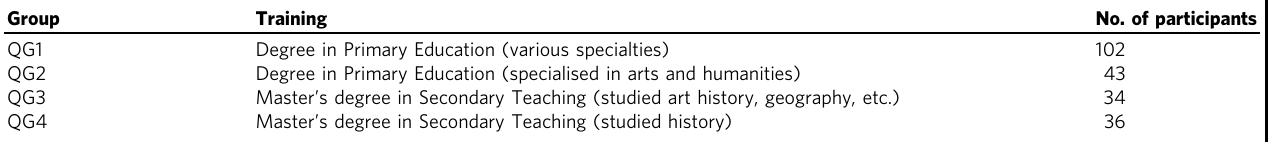
Table 1 Classi fi cation in groups of the participants in the fi rst phase.